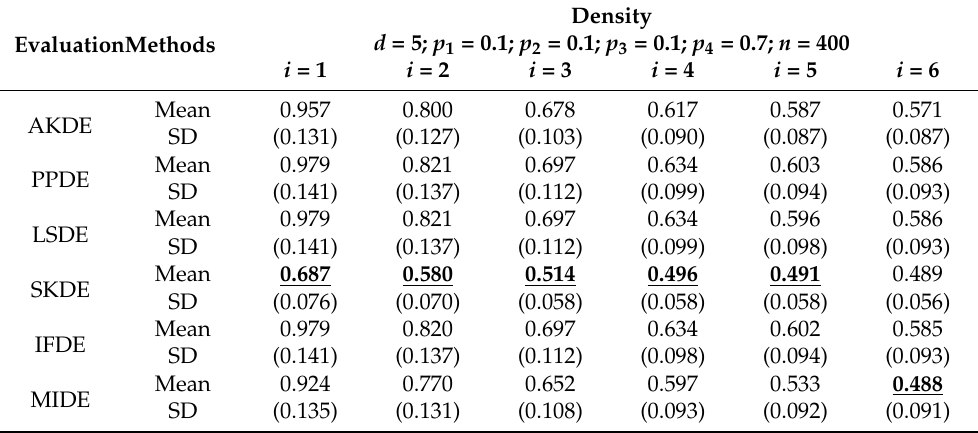
Table A6. 10 4 times upscaled mean absolute error with d = 5; p 1 = 0.1; p 2 = 0.1; p 3 = 0.1; p 4 = 0.7; n =